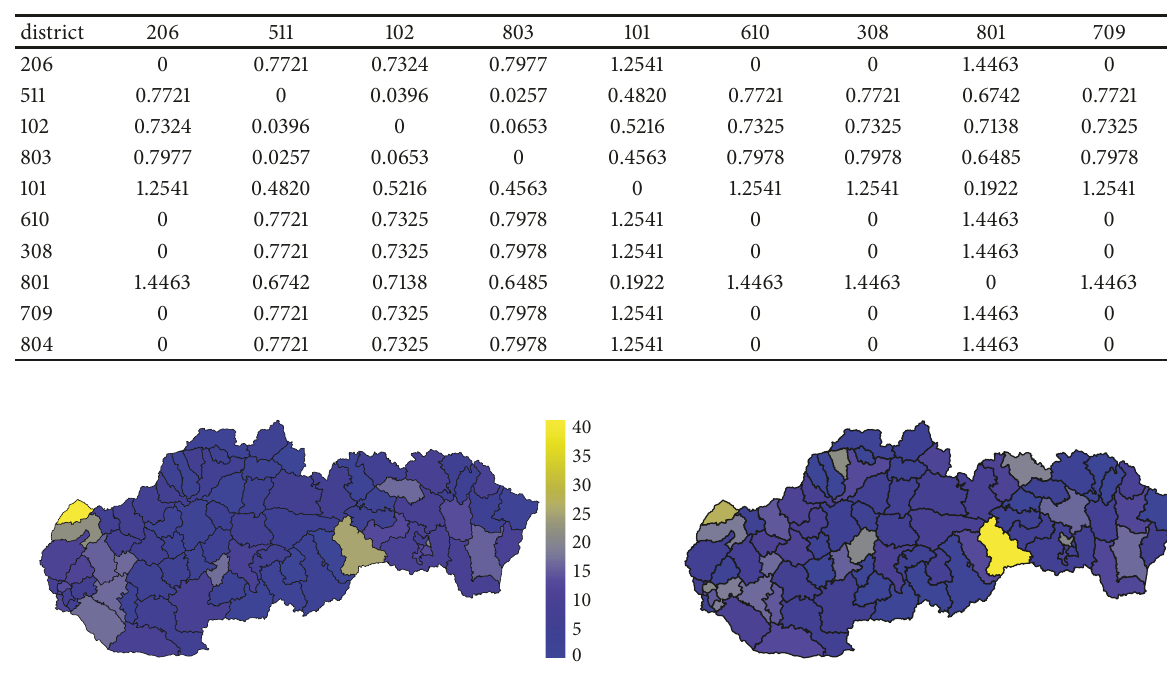
Table 4: The distance matrix of the ten most extreme districts for the male sex in 2015.